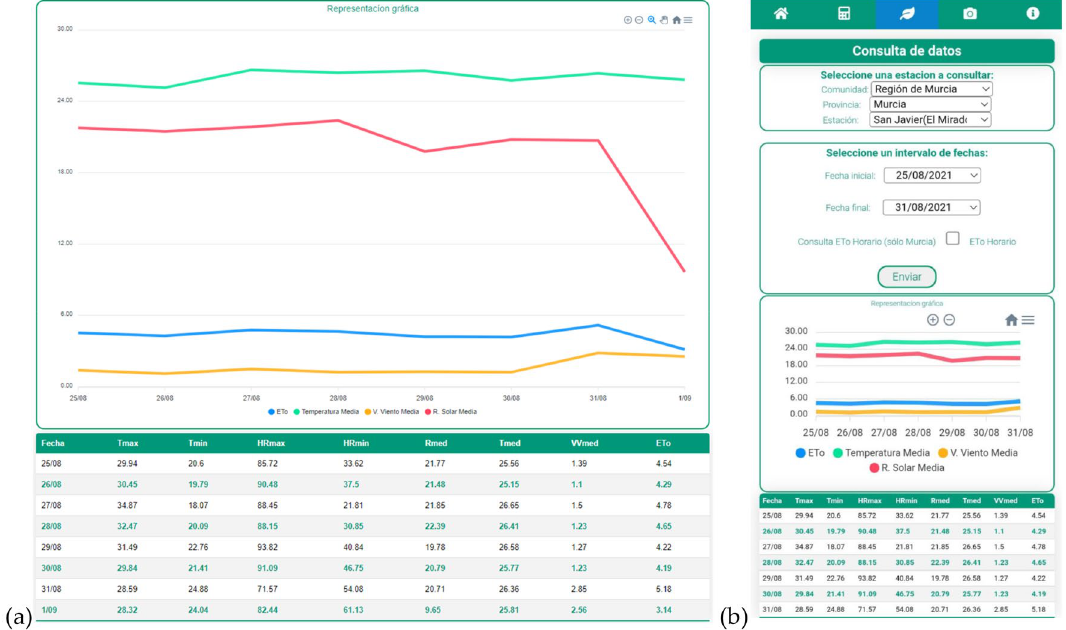
Figure 6. View of the Data tab as a graph and table in ( a ) the web application and ( b ) the mobile device.